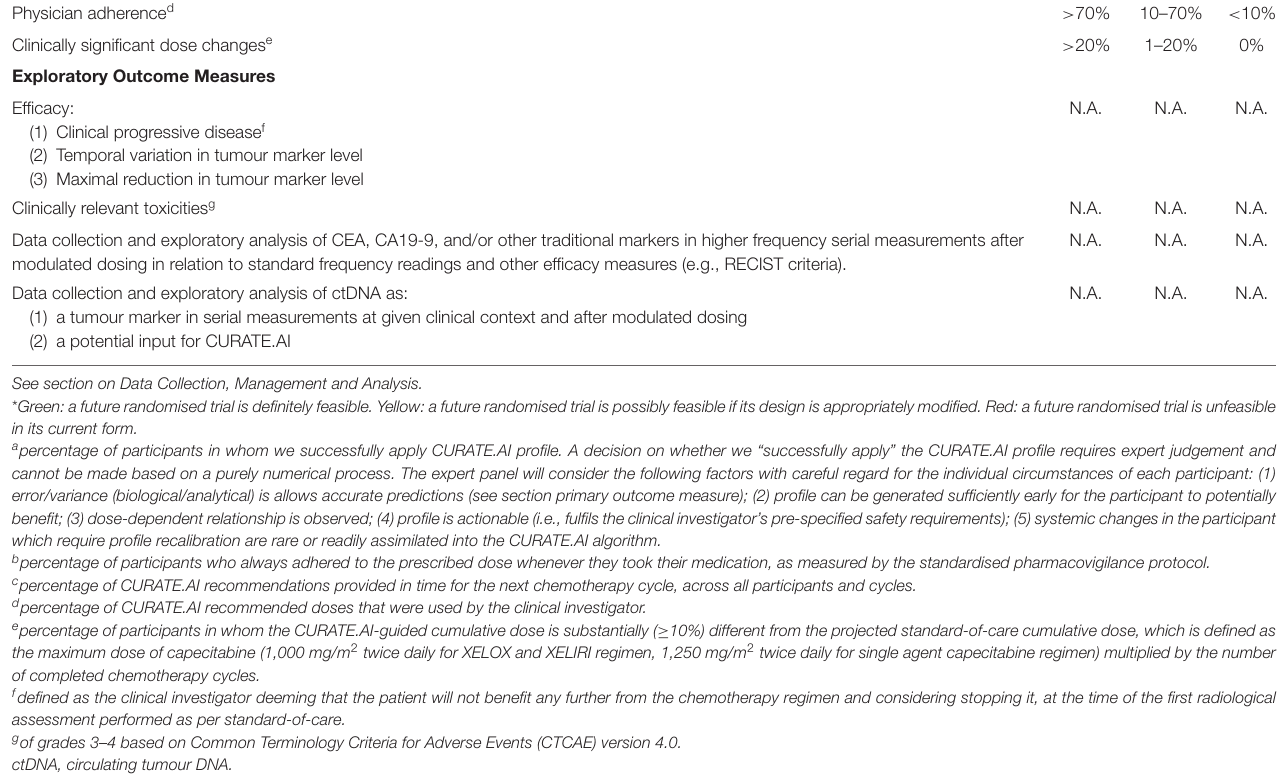
TABLE 1 | Outcome measures and progression criteria for the PRECISE CURATE.AI pilot clinical trial, based on “the traffic light system” recommended in the CONSORT extension statement for pilot clinical trials (33). Outcome measures Green* Yellow* Red* Primary Outcome Measures Applicability of CURATE.AI profiles a Secondary Outcome Measures Patient adherence